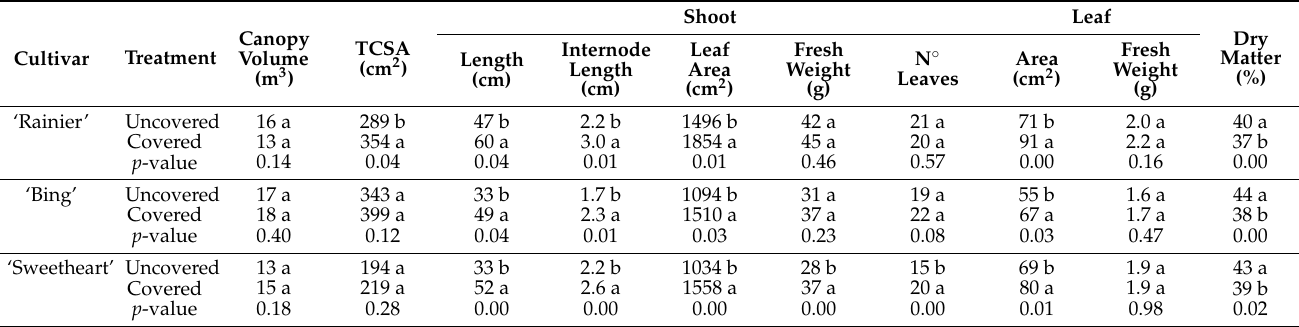
Table 3. Vegetative growth of sweet cherry cv. ‘Rainier’, ‘Bing’ and ‘Sweetheart’ with and without late-season rain